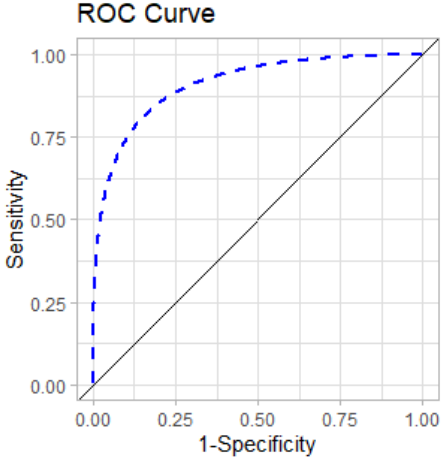
Figure 4. Receiver Operating Characteristics (ROC) curve